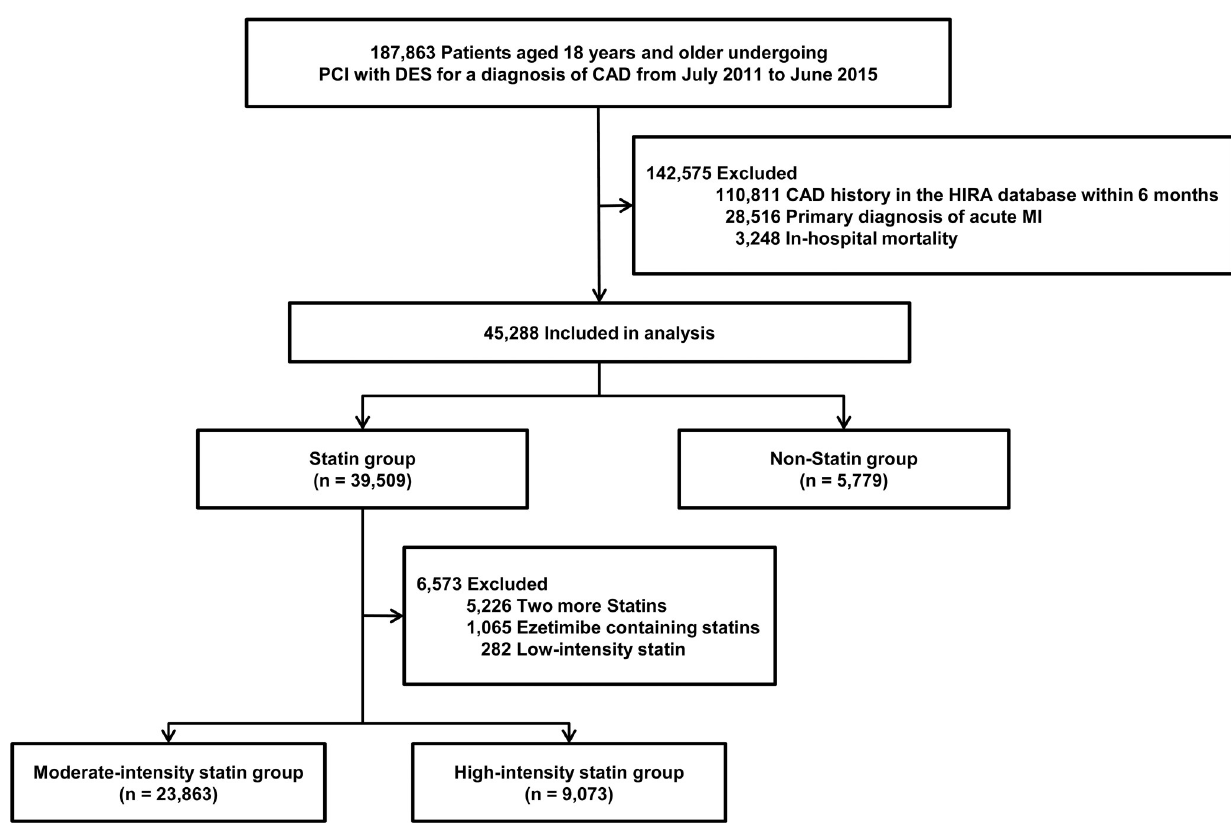
Fig 1. Overview of the study population. CAD = coronary artery disease; DES = drug-eluting stents; HIRA = the Health Insurance Review & Assessment Service; MI = myocardial infarction; PCI = percutaneous coronary intervention. https://doi.org/10.1371/journal.pone.0207889.g001 PLOS ONE | https://doi.org/10.1371/journal.pone.0207889 December7,